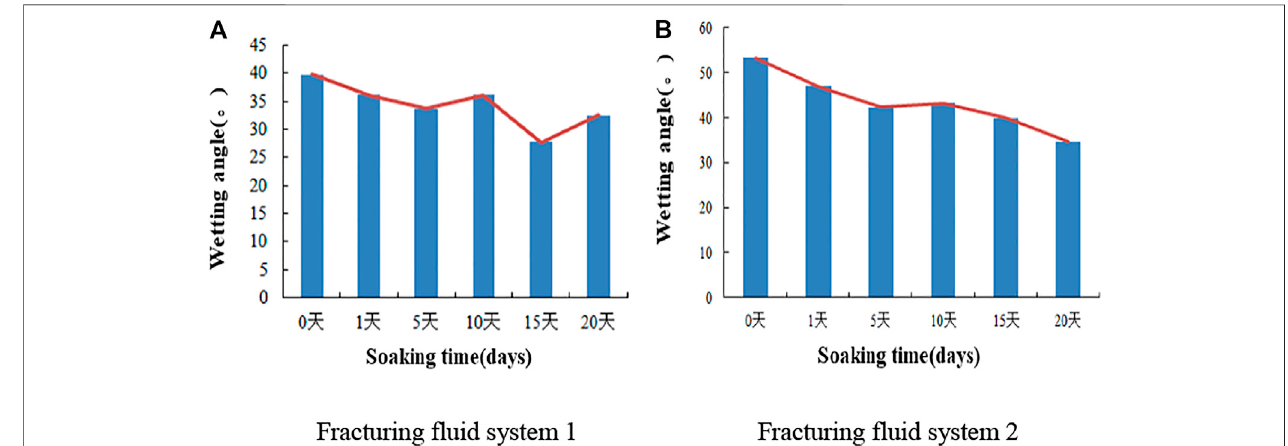
FIGURE 3 | Changes of the wetting angle with the soaking